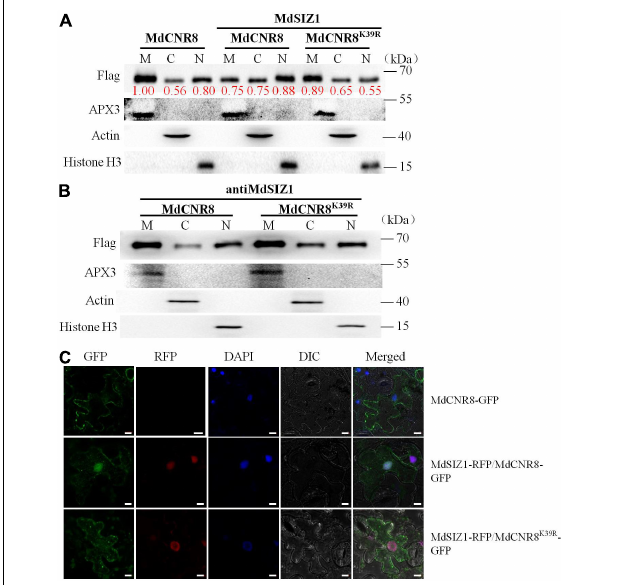
FIGURE 5 | MdSIZ1 increases nuclear localization of MdCNR8. (A,B) The abundance of MdCNR8 or MdCNR8 K39R separated from cell membrane, cytoplasm, and nuclei in the presence (A) or absence (B) of MdSIZ1-GFP. M, cell membrane; C, cytoplasm; N, cell nuclei. The red numbers indicate the quantification of the protein band brightness. (C) Fluorescent detection of MdCNR8 subcellular localization in tobacco leaves. MdCNR8-GFP only or MdSIZ1-RFP combined with either MdCNR8-GFP or MdCNR8 K39R -GFP constructs were coexpressed transiently in tobacco leaves and visualized by fluorescence microscopy. DAPI was used to stain the nuclei. GFP, green fluorescent protein; RFP, red fluorescent protein; DIC, bright field. Bars = 20 µ